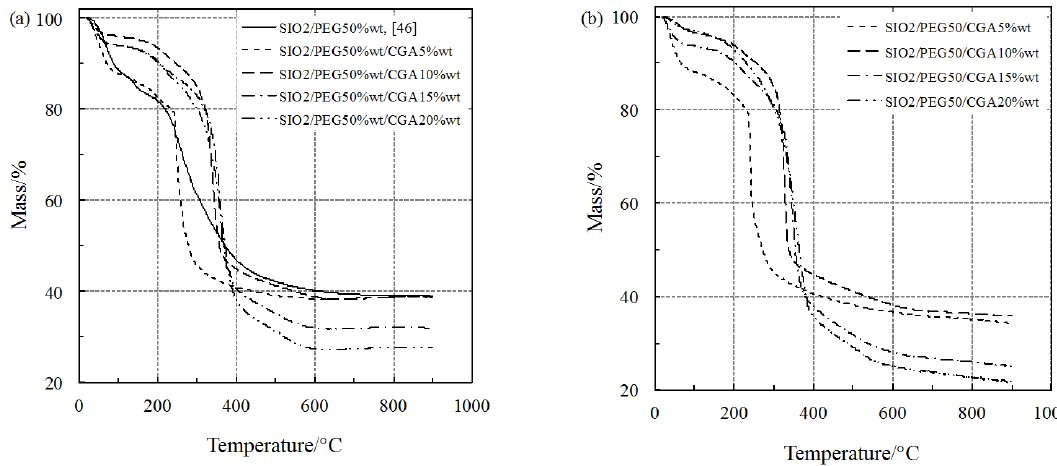
Figure 5. TG curves of SiO 2 /PEG and SiO 2 /PEG/CGA hybrids at 10°C min −1 under a flowing atmosphere of: nitrogen ( a ); air ( b ).